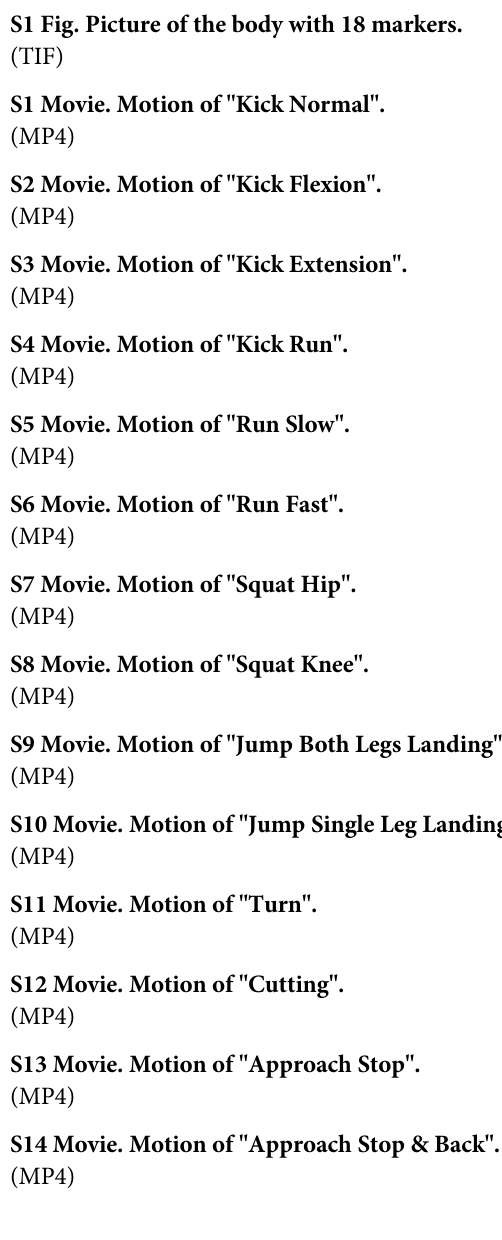
S1 Fig. Picture of the body with 18